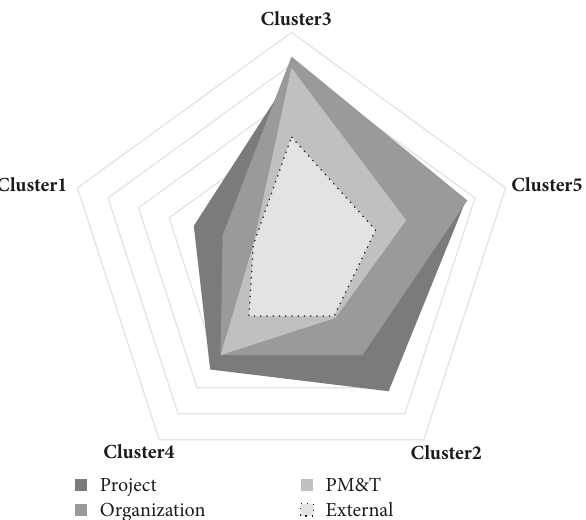
Figure 13: Radar chart representing the average rate of each cluster in each